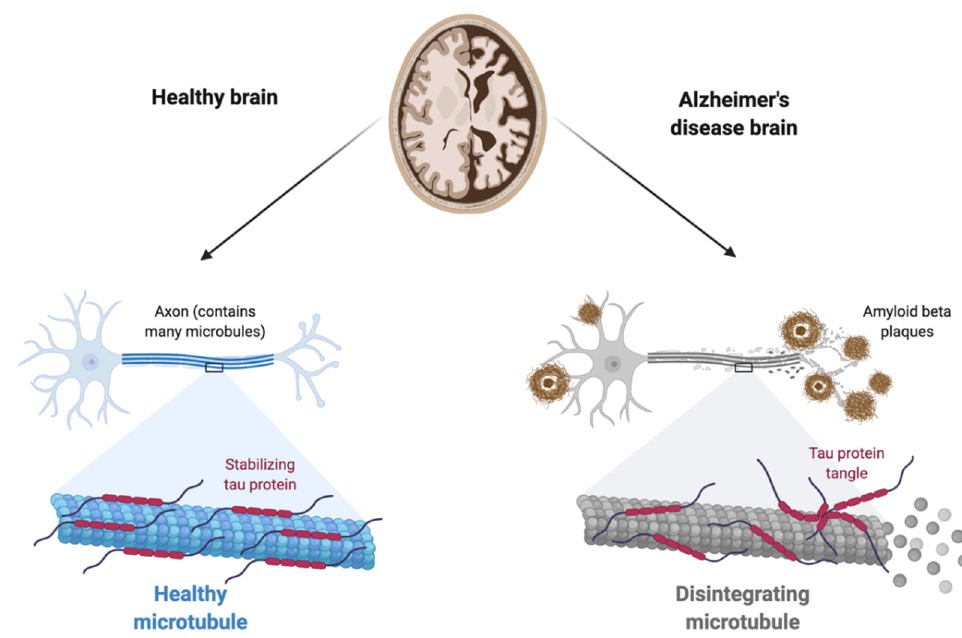
Figure 2. Differences between a healthy brain and an Alzheimer’s disease brain.